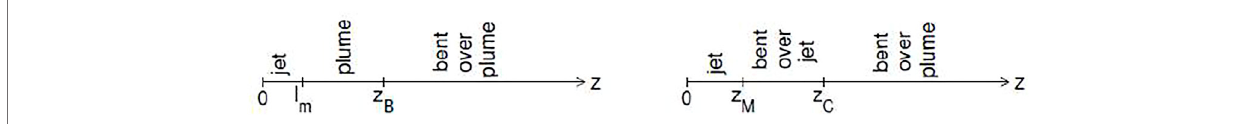
FIGURE 1 | Length scales and fl ow regimes of a buoyant jet in cross fl ow in case z B > z M ( left ) orincase z M > z B ( right ) with z C (cid:1) z M ( z M z